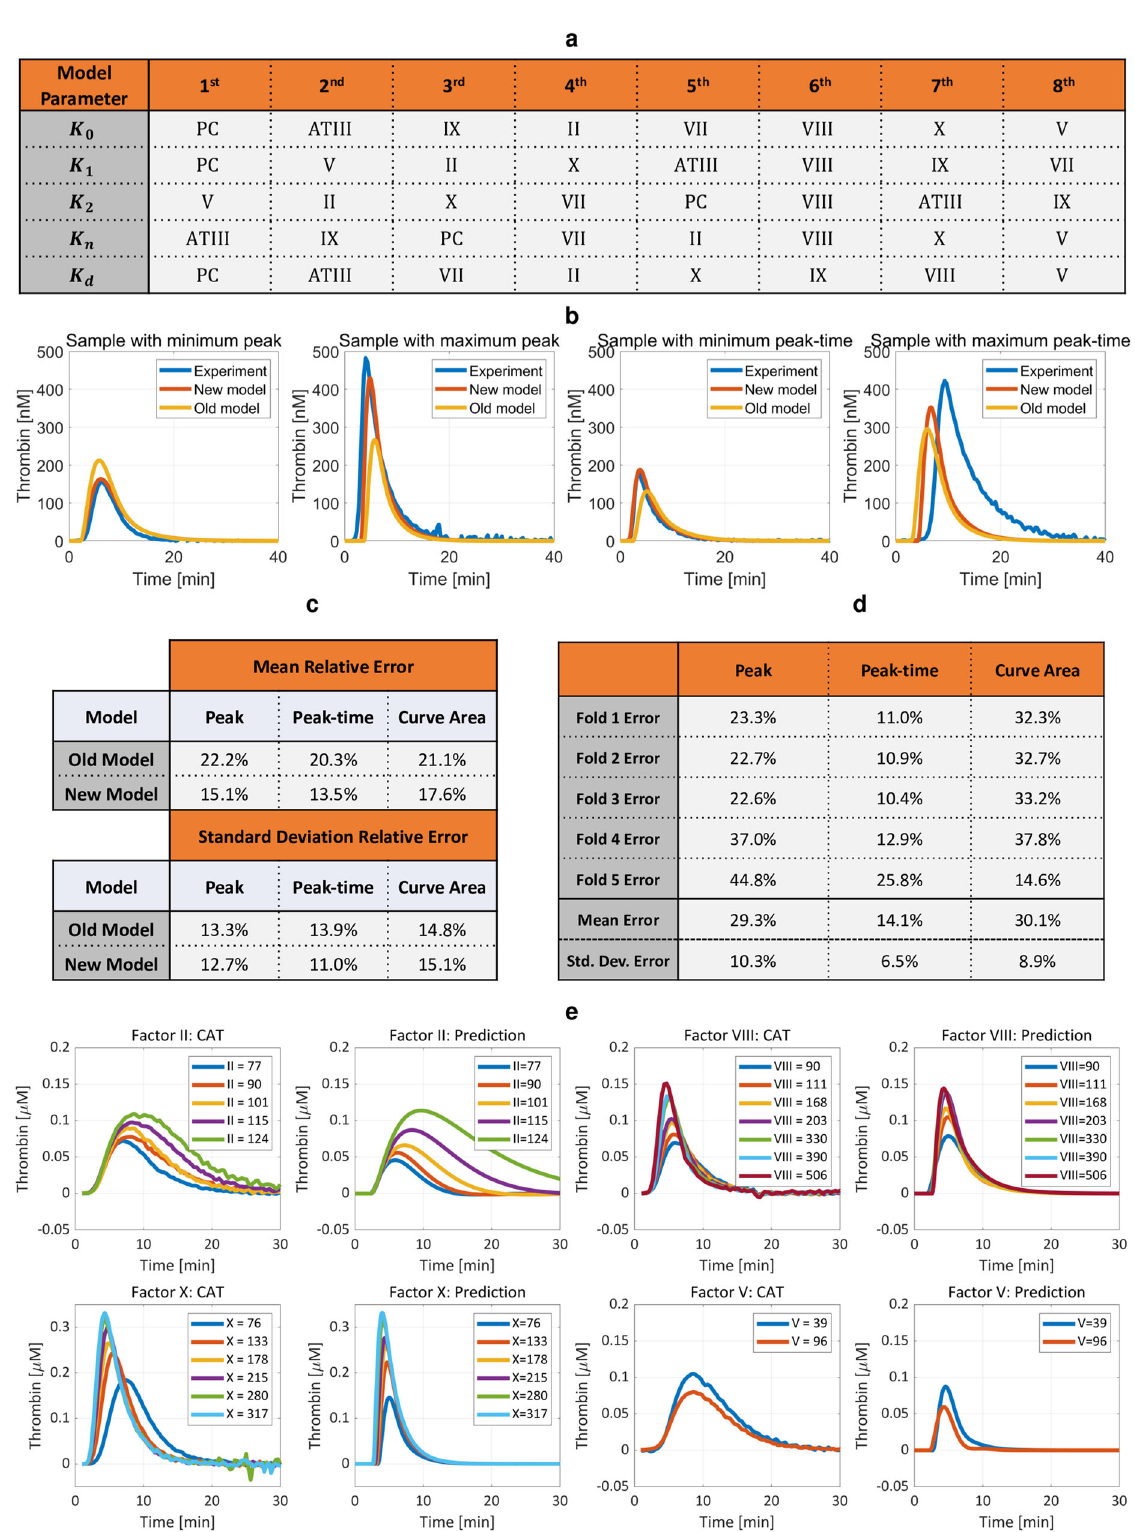
pro fi le was not within normal minimum and maximum bounds. (GCM) algorithm, Figs. 7 and 8, to recommend a personalized set of coagulation factor concentration changes to move